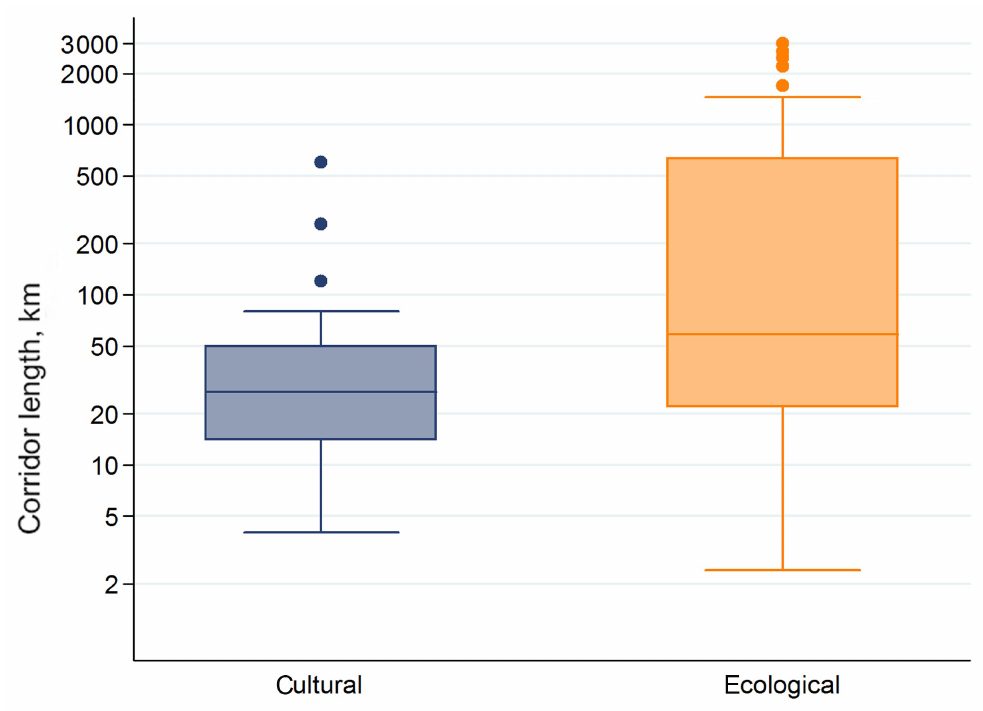
Figure 8. Boxplot of the lengths of cultural and ecological corridors (in